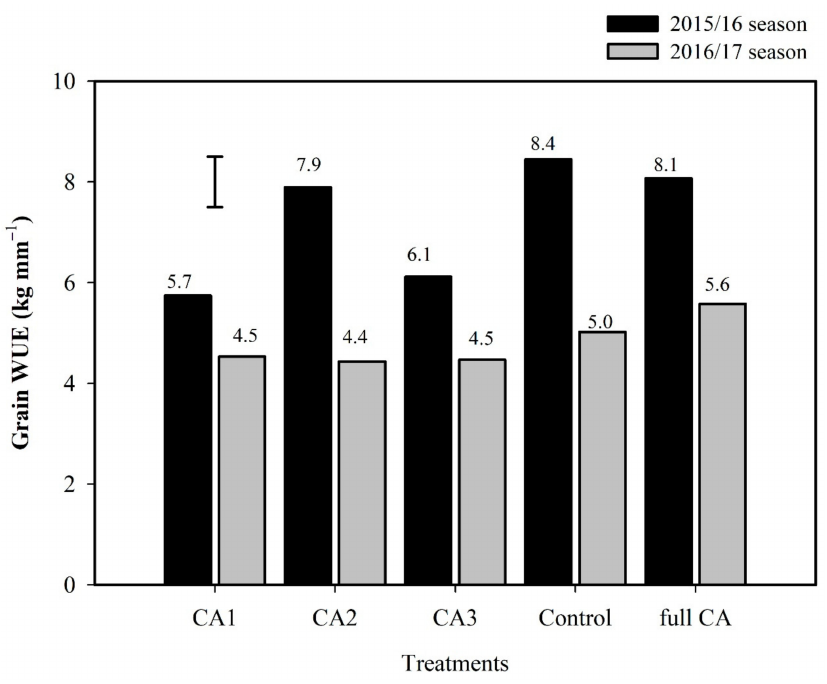
Figure 9. Grain water use efficiency in finger millet under conventional tillage only (control), con- ventional tillage + mulch (partial CA1), reduced tillage only (partial CA2), reduced tillage + mulch (partial CA3) and reduced tillage + mulch + intercropping with cowpea (full CA) treatments under finger millet during 2015/16 and 2016/17 cropping seasons. Error bar represents LSD 0.05